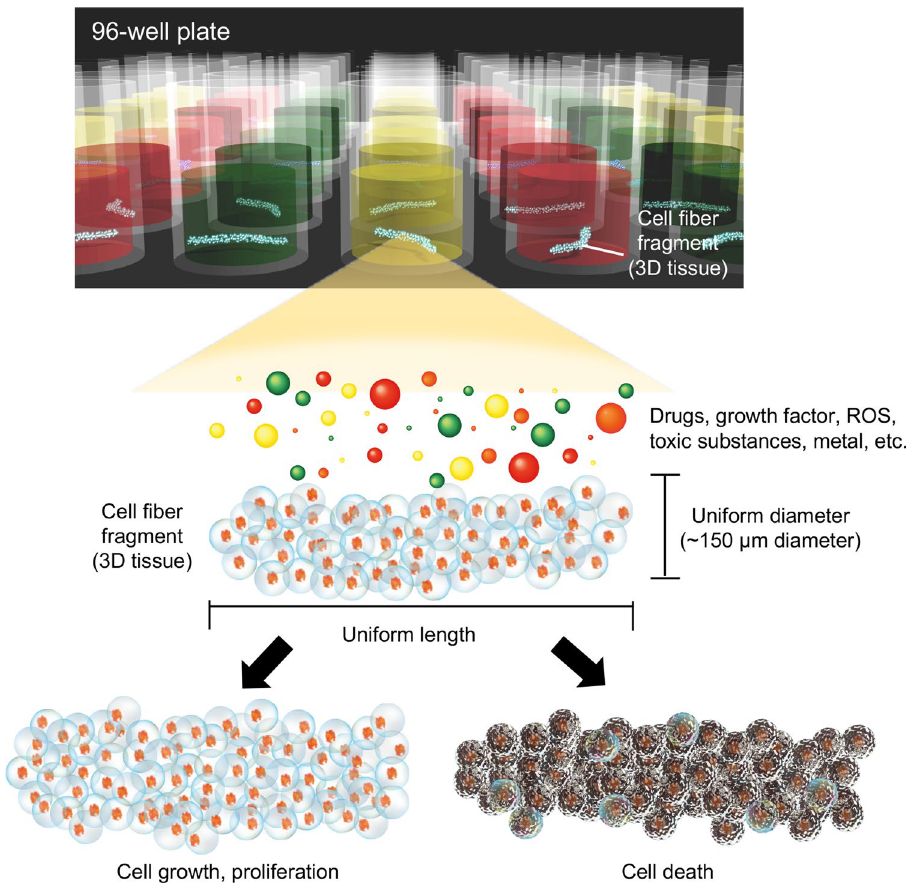
Figure 1. Conceptual illustration of drug screening using an array of the CF fragments on a 96-well plate. We propose an array of the CF fragments formed on a 96-well plate from cell fibers of uniform shape and size as a 3D tissue array for drug screening. Cell viability after drug treatment was detected as a luminescence signal proportional to the adenosine triphosphate (ATP) content of the